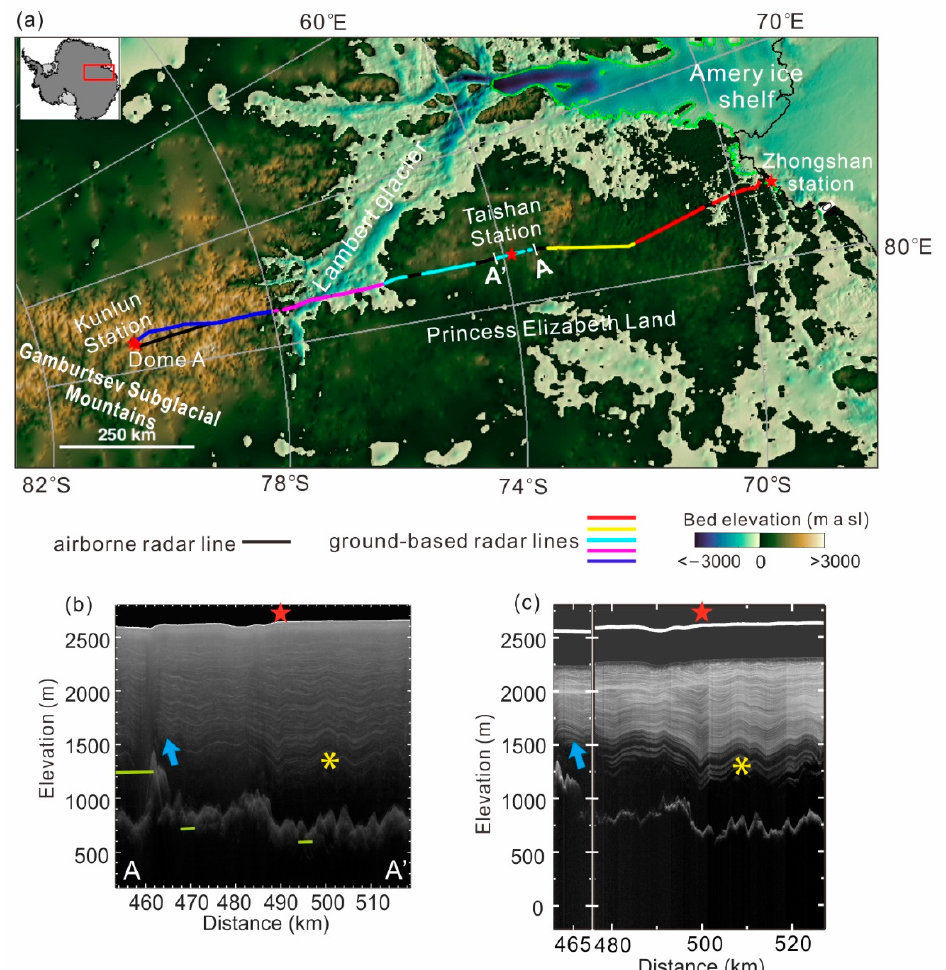
Figure 2. ( a ) The distribution of the detection routes on maps. The base map is from Antarctic BedMachine V2 (Morlighem et al., 2019). ( b ) Airborne radar images from route A’-A. ( c ) Ground-based radar image from Luo et al., 2020 [18]. The locations of the Taishan Station are indicated by red stars in ( b , c ). The Yellow * and blue arrow indicate the observation results of similar structures in different radar